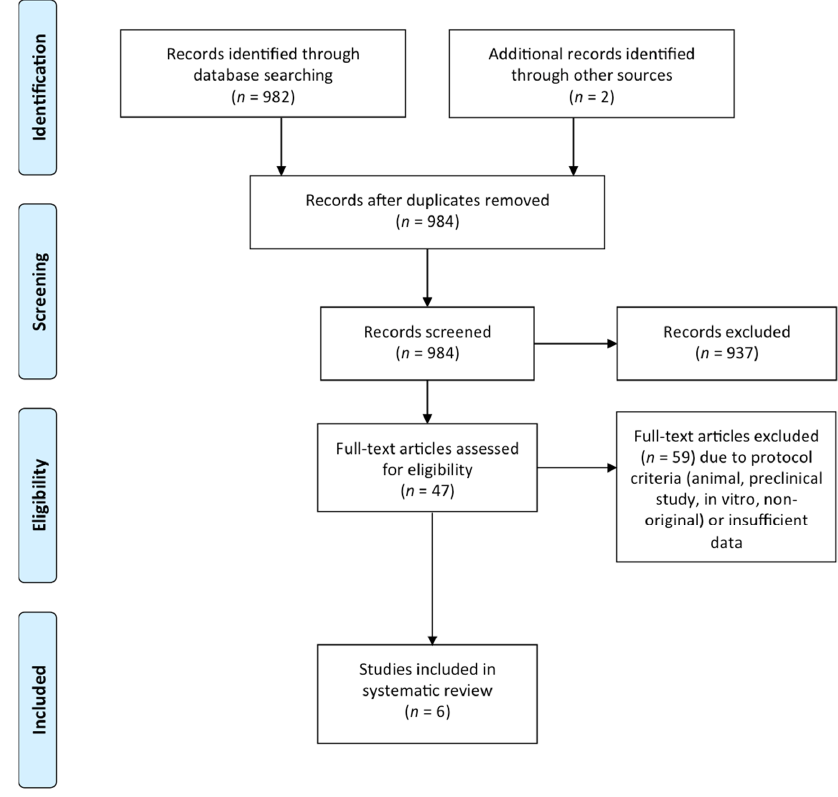
Figure 1. Flow chart of identified studies.